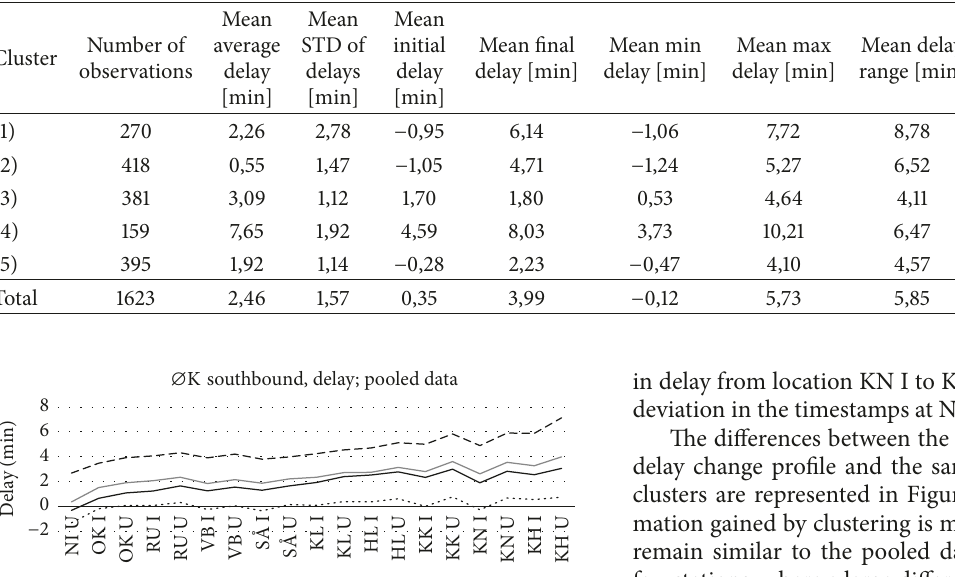
Figure 3: Delays recorded for ØK southbound trains. 15th per- centile: dotted; median: solid black; 85th percentile: dashed; average: solid